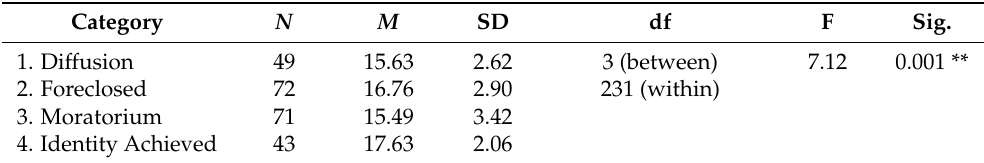
Table 2. Descriptives: Family History Knowledge and Marcia’s Identity Stages